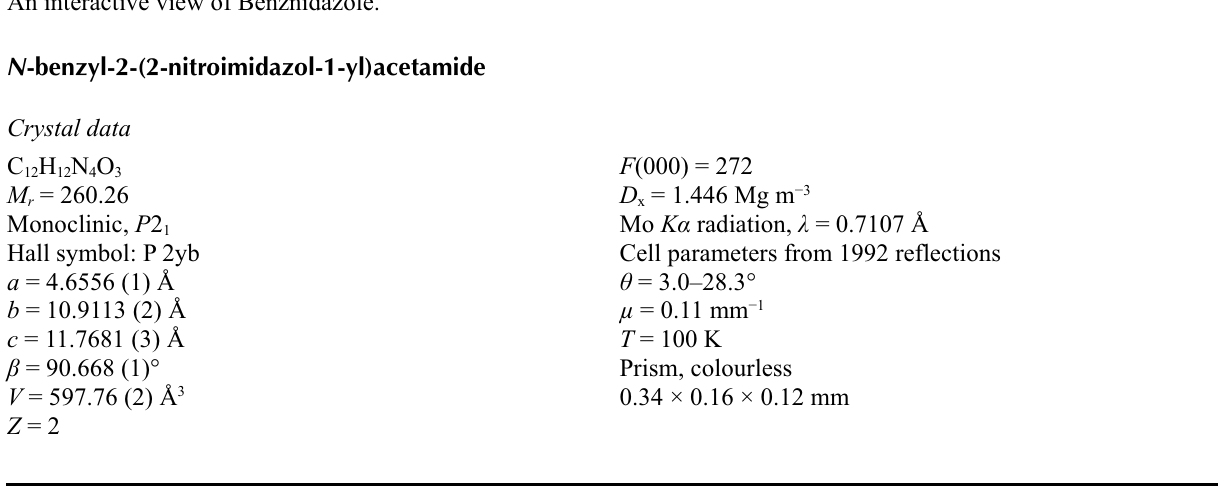
An interactive view of